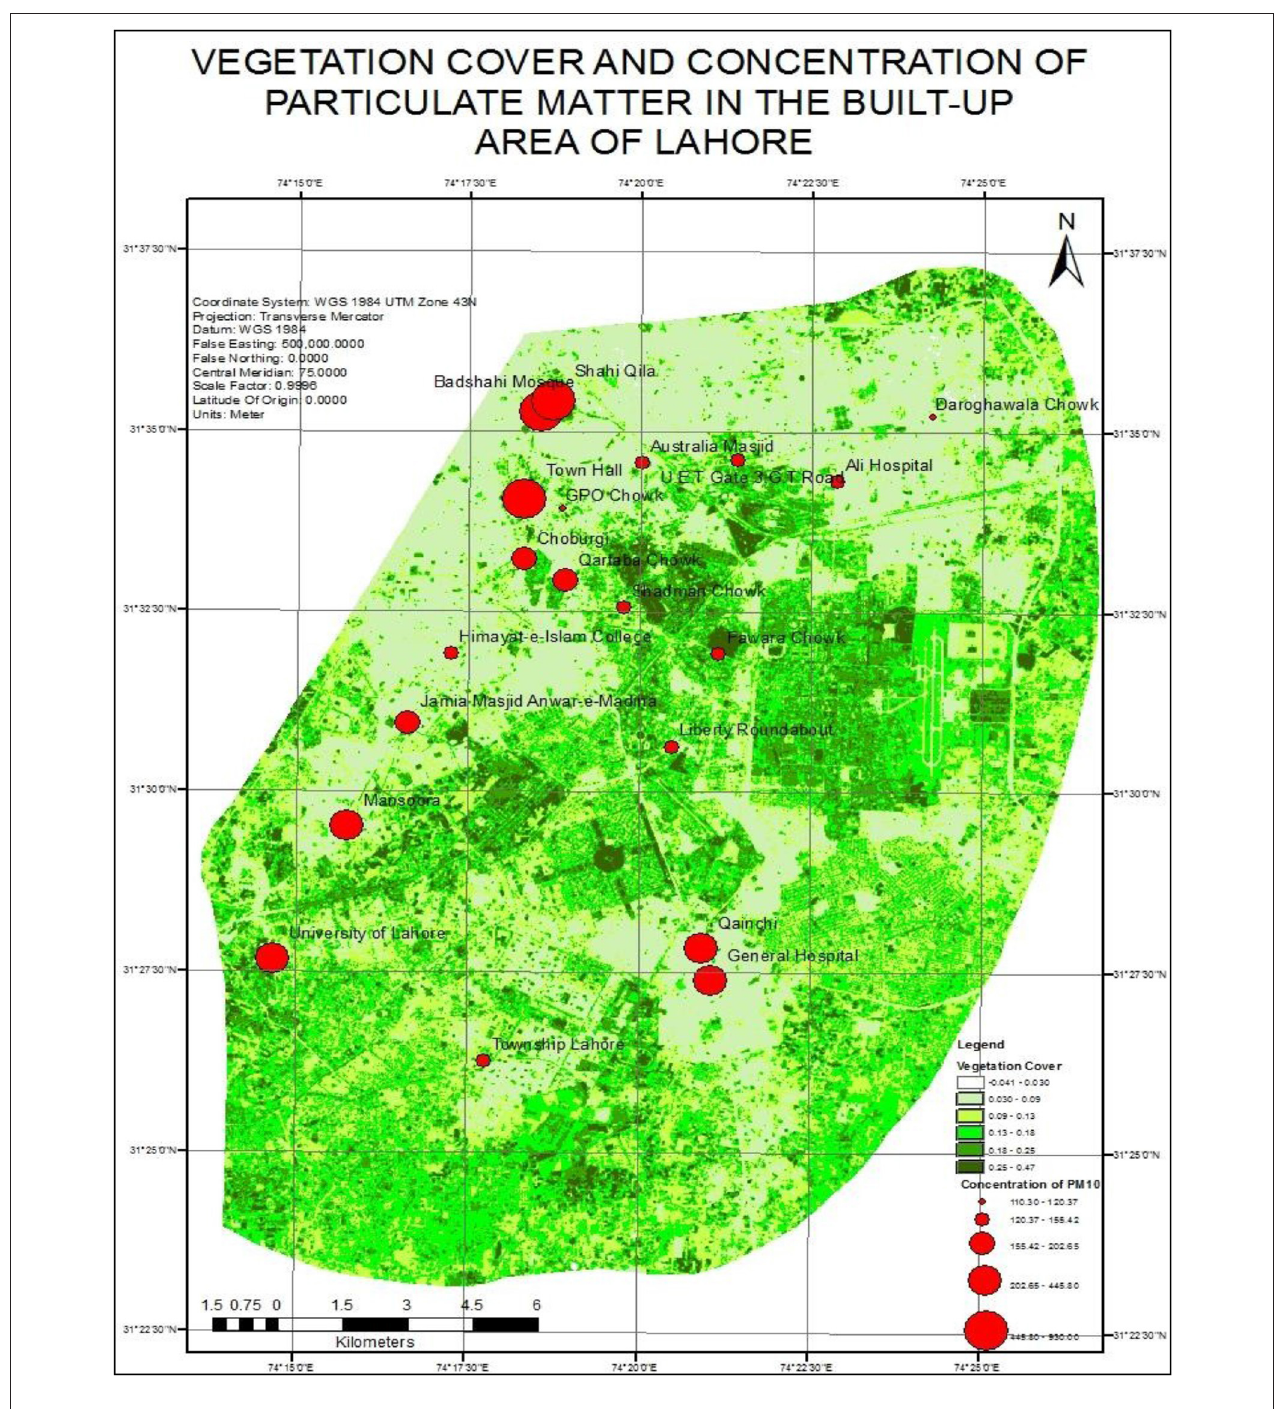
FIGURE 14 | Impact of vegetation and the concentration of particulate